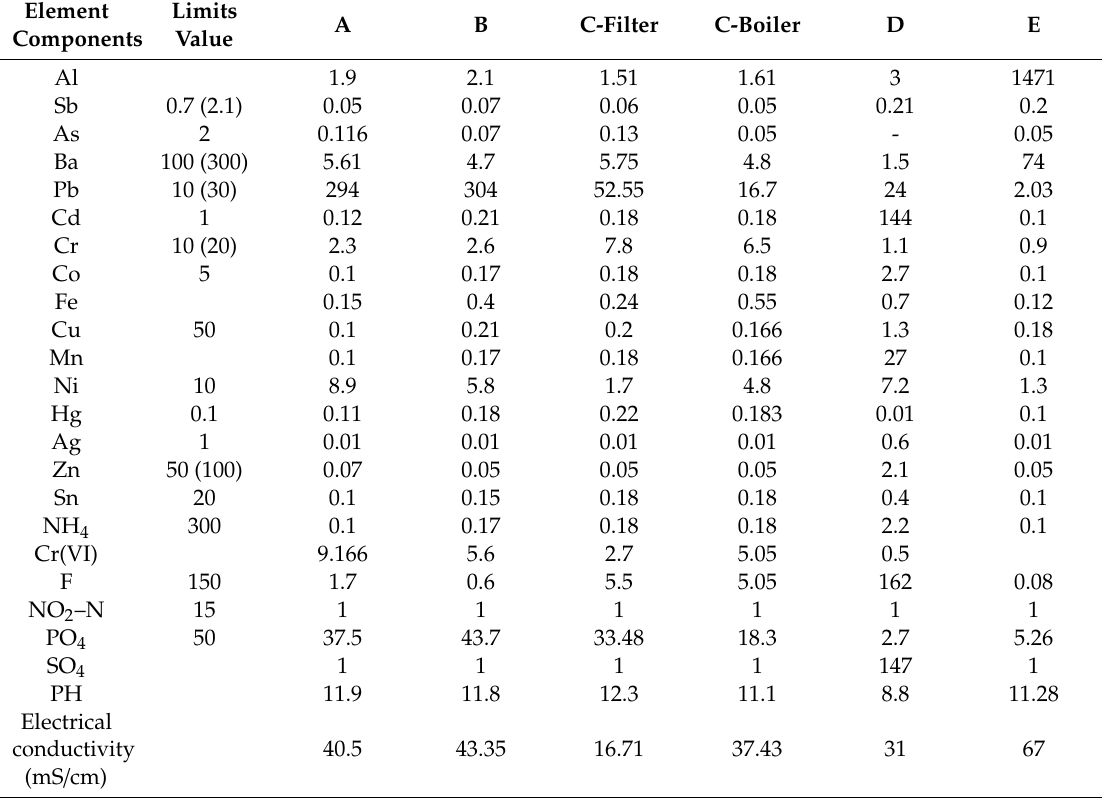
Table 9. Leaching contents (mg / kg) of heavy metals from ash